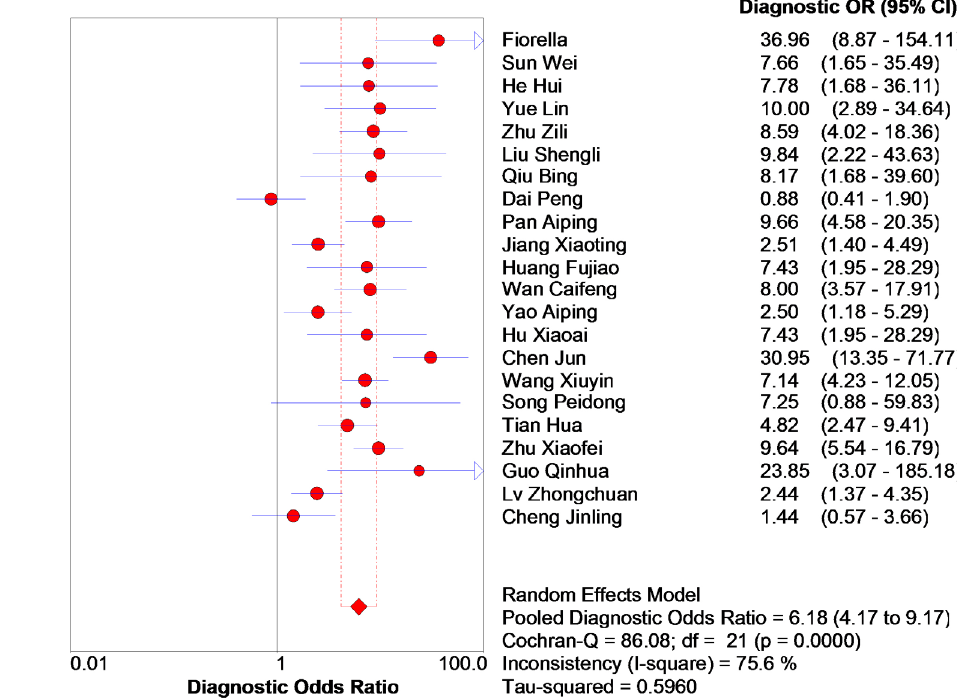
Figure 6: Combined negative likelihoodratio(negative LR) for serum CA72-4 in the diagnosis of colorectal cancer